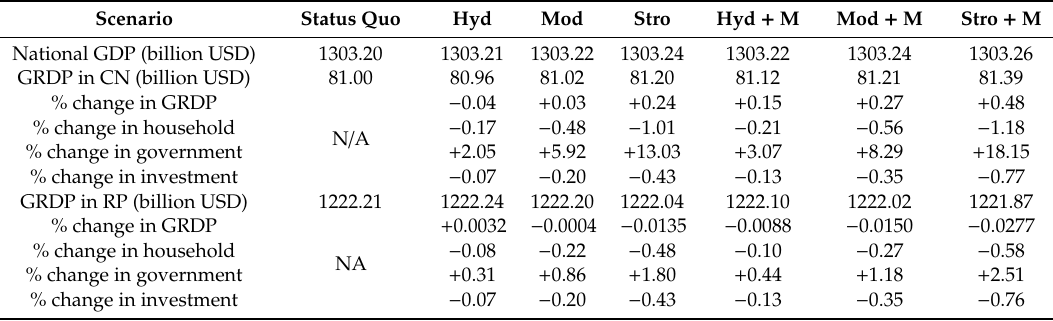
Table 3. Comparison of GRDP under di ff erent scenarios for CN and